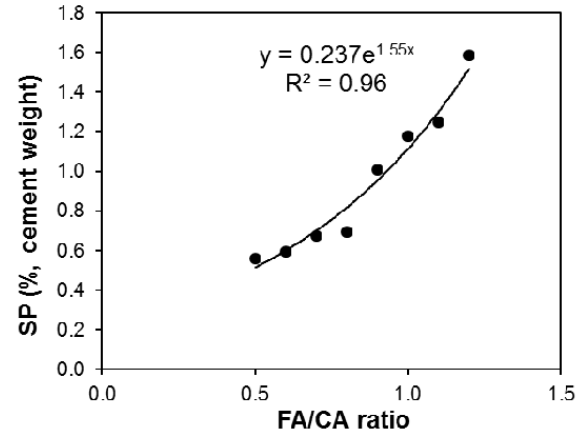
Figure 7. SP dosage (%) vs. FA/CA ratio for concrete.